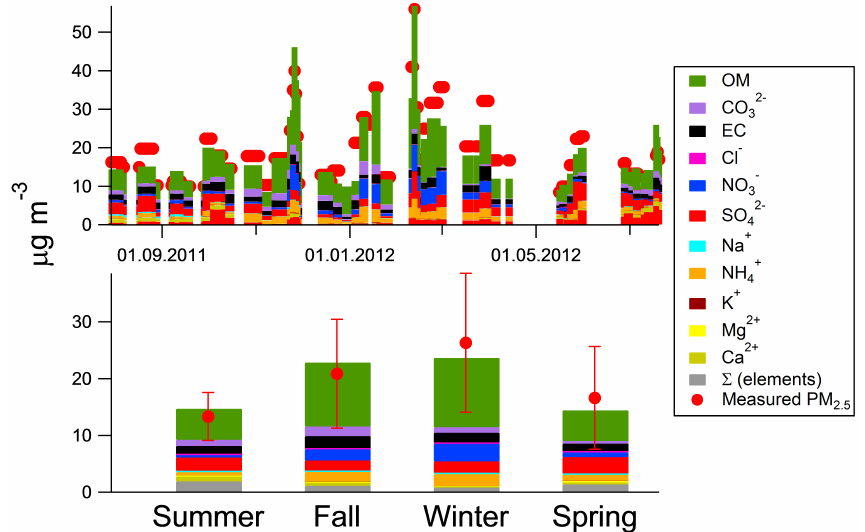
Figure 1. PM 2 . 5 composition: stacked average seasonal concentrations. Measured PM 2 . 5 error bars represent the seasonal standard deviation. OM was estimated as the sum of the offline-AMS source apportionment factors.